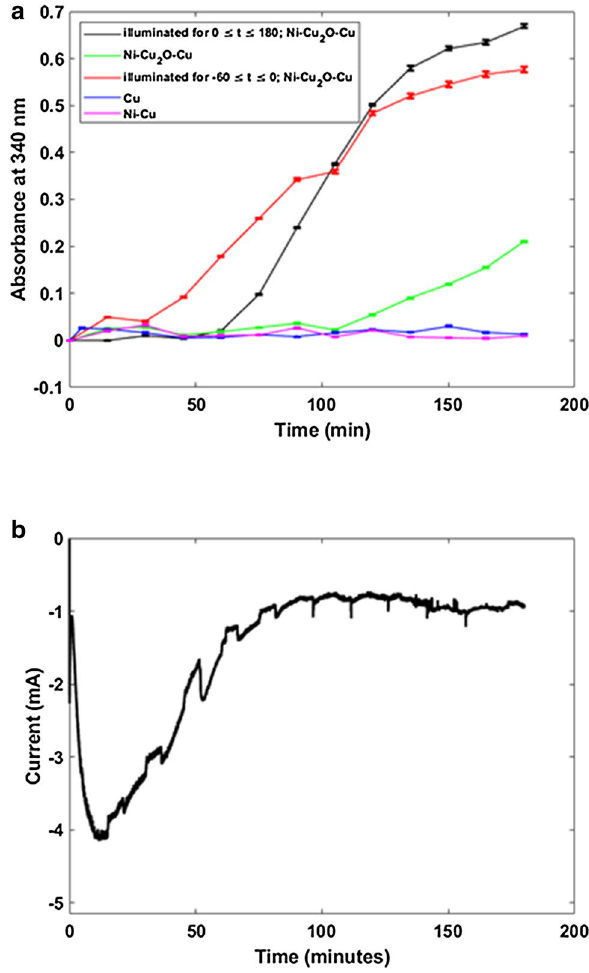
Figure 6. Cofactor regeneration with different cathode materials and conditions of illumination. ( a ) Absorption at 340 nm for NADPH (product) versus time for electrochemical reduction in the presence of illumination for the entire duration of the experiment with the nanostructured heterolayer electrode (black curve); illumination of the nanostructured heterolayer cathode first for 60 min, followed by electrochemical reduction (red); electrochemical reduction with a non-modified nanostructured heterolayer electrode in the absence of illumination (green); electrochemical reduction with the Cu mesh alone and in the absence of illumination (dark blue); and electrochemical reduction with Ni sputtered on the Cu mesh alone and in the absence of illumination (magenta). The time point t = 0 represents the instant when electrochemical reduction is initiated. Error bars represent the standard deviation of 30 sequential absorbance measurements on the same aliquot. ( b ) Current trace versus time for the nanostructured heterolayer (as fabricated and not surface modified) electrode in the presence of both 532 nm (10 mW) laser illumination and electrochemical